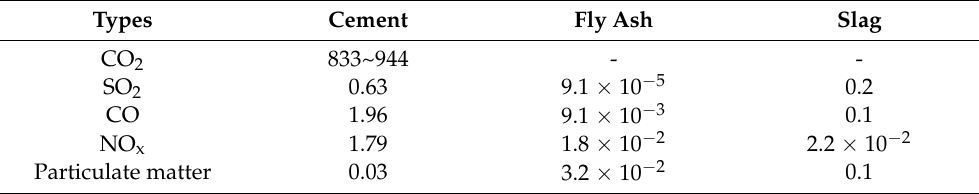
Table 3. Harmful emissions per ton of cementitious materials (kg) [53,80,81].